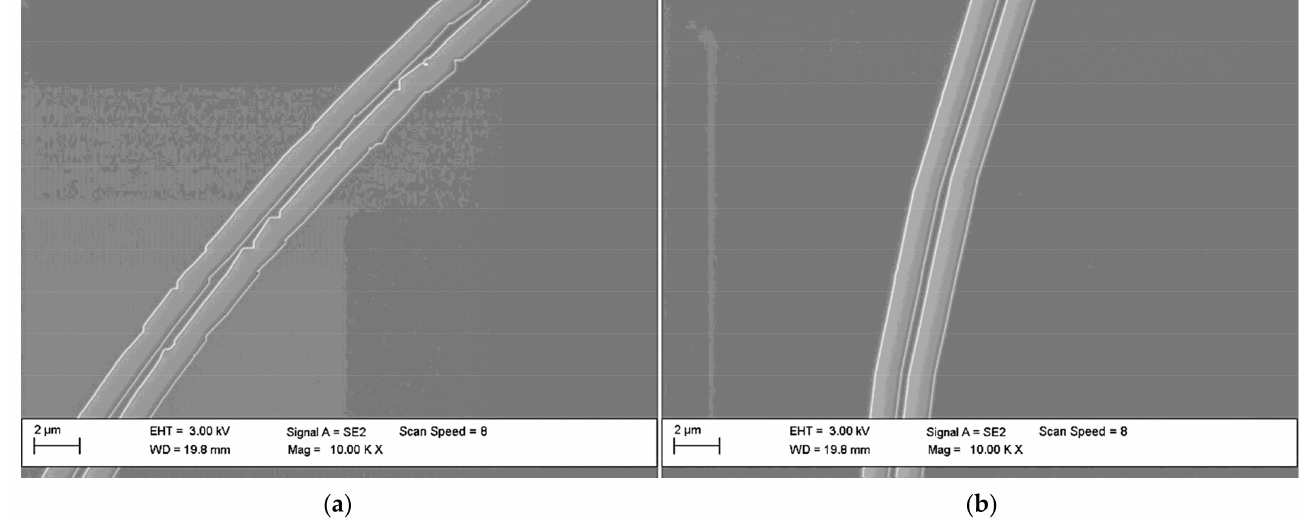
Figure 11. Pattern fracturing: ( a ) before optimization; ( b ) after optimization.